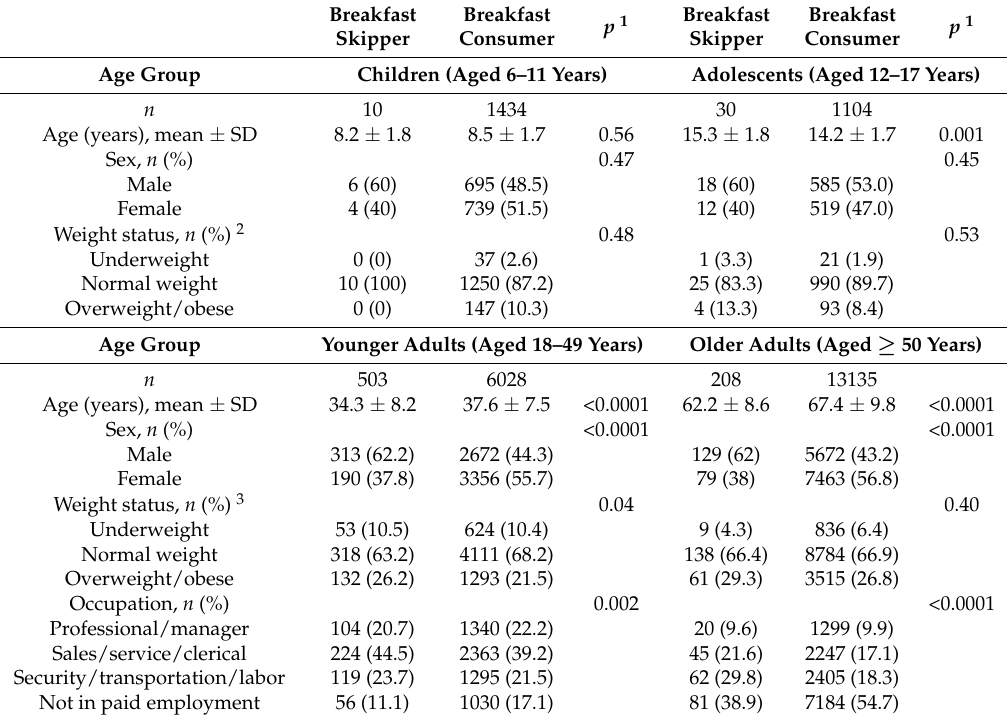
Table 1. Basic characteristics of breakfast skippers and